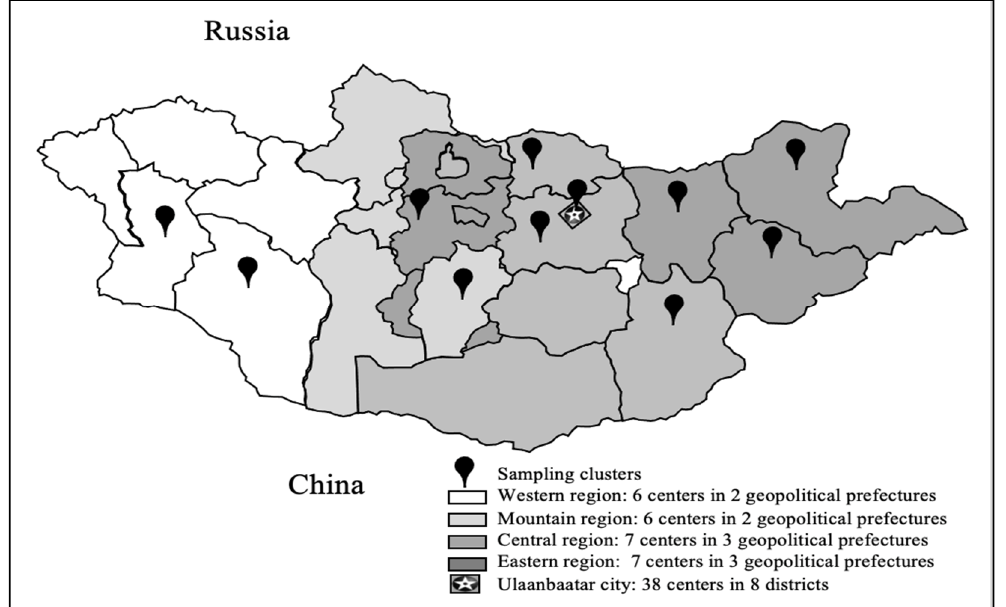
Figure 2. Sampling clusters.